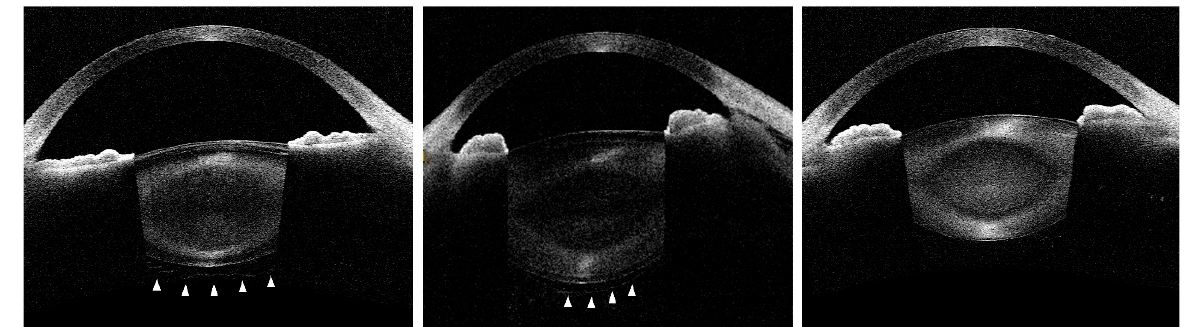
Figure 1. Representative AS-OCT images. ( Left ): Complete detachment of anterior hyaloid mem- brane (AHM) was observed (arrow heads). ( Middle ): AHM detachment was partially seen (arrow heads). ( Right ): AHM was not visible.